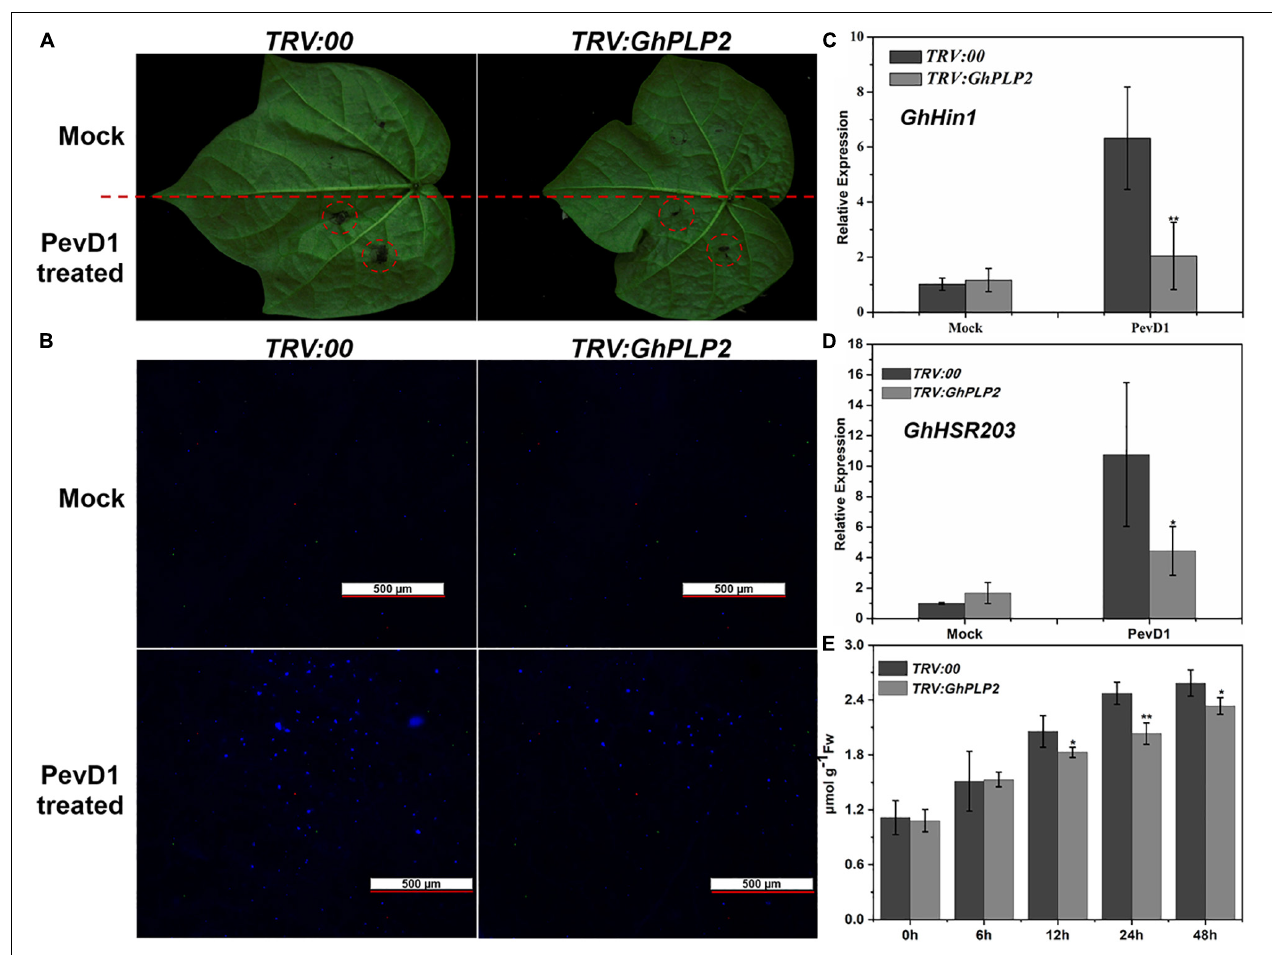
FIGURE 6 | GhPLP2 -mediated HR triggered by the Verticillium dahliae elicitor PevD1. (A) HR phenotypes developed on the leaves after injection with the PevD1 elicitor. (B) Callose deposition on the infected leaves at 24 h after injection. Scale bar represents 500 µ m. (C,D) The expression of HR marker genes GhHIN1 and GhHSR203 . (E) Detection of H 2 O 2 in the leaves during injection with PevD1. Data were obtained from three independent biological replicates. Asterisks indicate a significant difference, as determined by Student’s t -test. ( *P < 0.05, **P <